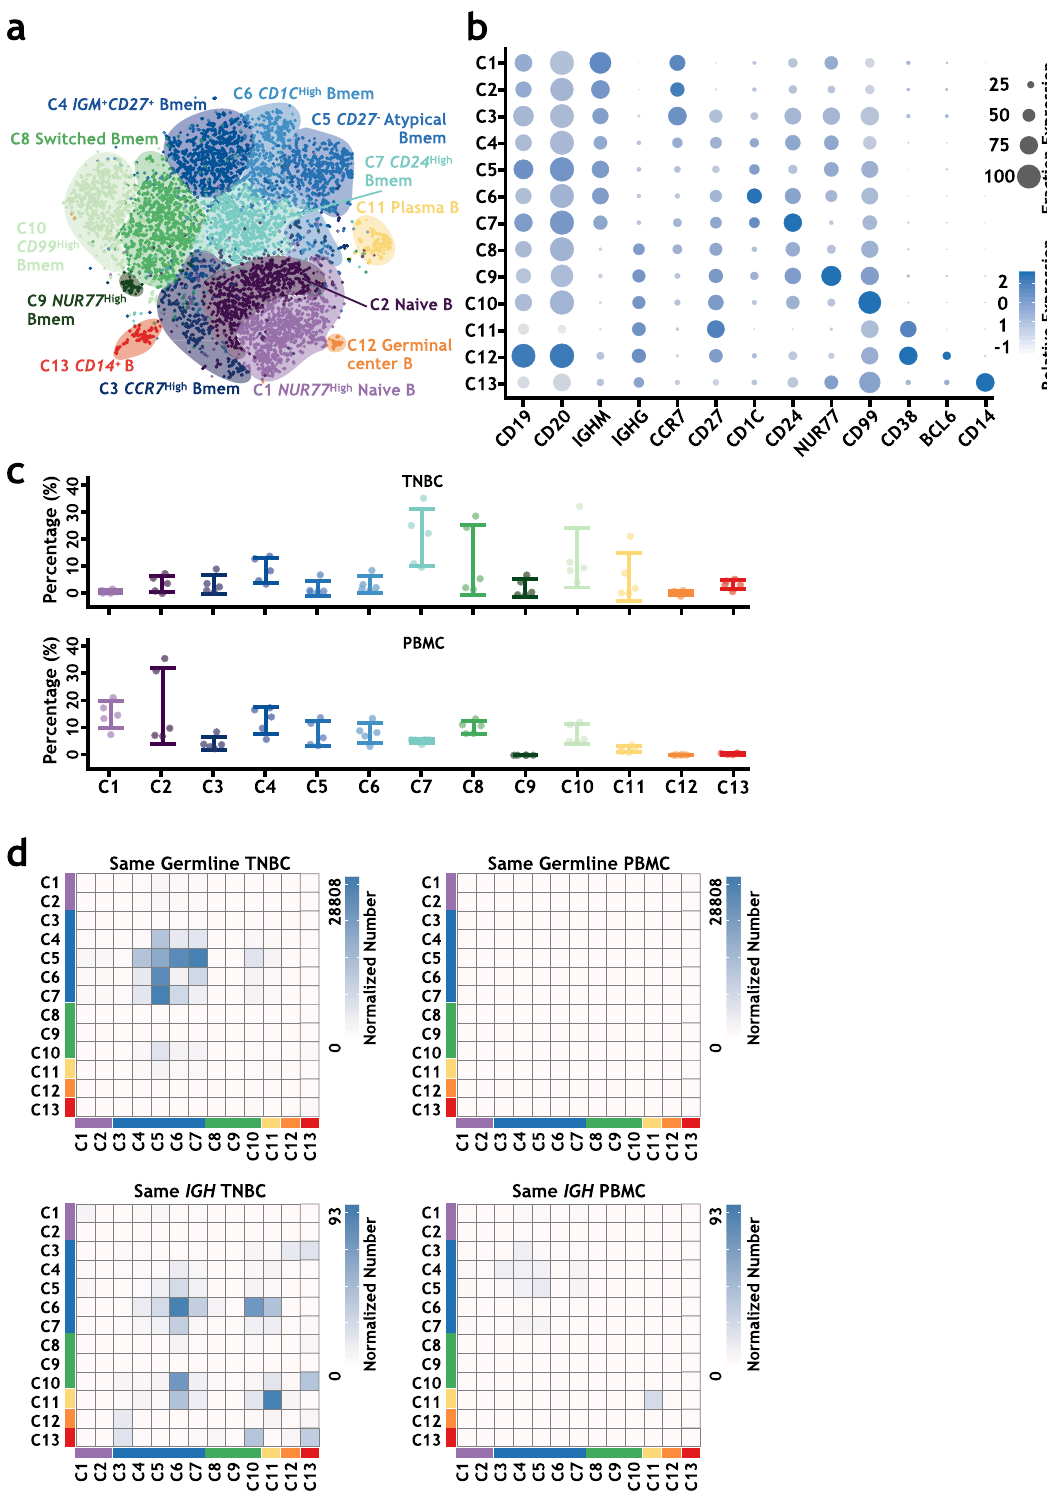
Fig. 4 Single-cell transcriptome analysis and IGH lineage analysis of B cells from TNBC patients at a higher resolution. a The t-SNE projection of 8632 B cells from TNBC patients shows 13 major cellular clusters at a higher resolution. b Selected marker genes to de fi ne each B cell cluster. c The distributions of 13 clusters in each patient sample (upper panel: PBMC; lower panel: TNBC). X represents B cell clusters, and Y represents the cell percentage in each sample. Each dot represents one sample, and error bars represent the mean ± standard deviation (SD) of the fi ve samples. d Heat maps show the distribution of the same germline event number (upper panel) and the same IGH sequence event number (lower panel) among the 13 B cell clusters for TNBC and PBMC samples. The same germline events were calculated using clonally related B cells, and the same V(D)J sequence events were calculated using B cells with the same observed IGH sequences. Then, the event numbers were normalized by the cell numbers of related B cell clusters and plotted in the heatmap. See “ Paired BCR and single-cell RNA-seq data analyses ” in the Methods section for details. Source data are provided as a source data fi